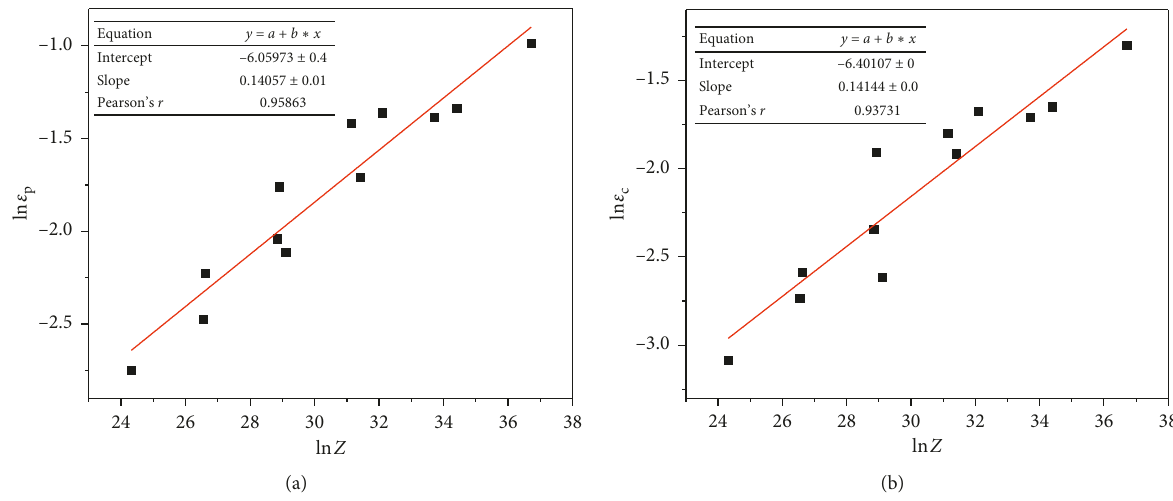
Figure 8: Relationships between (a) ln ε